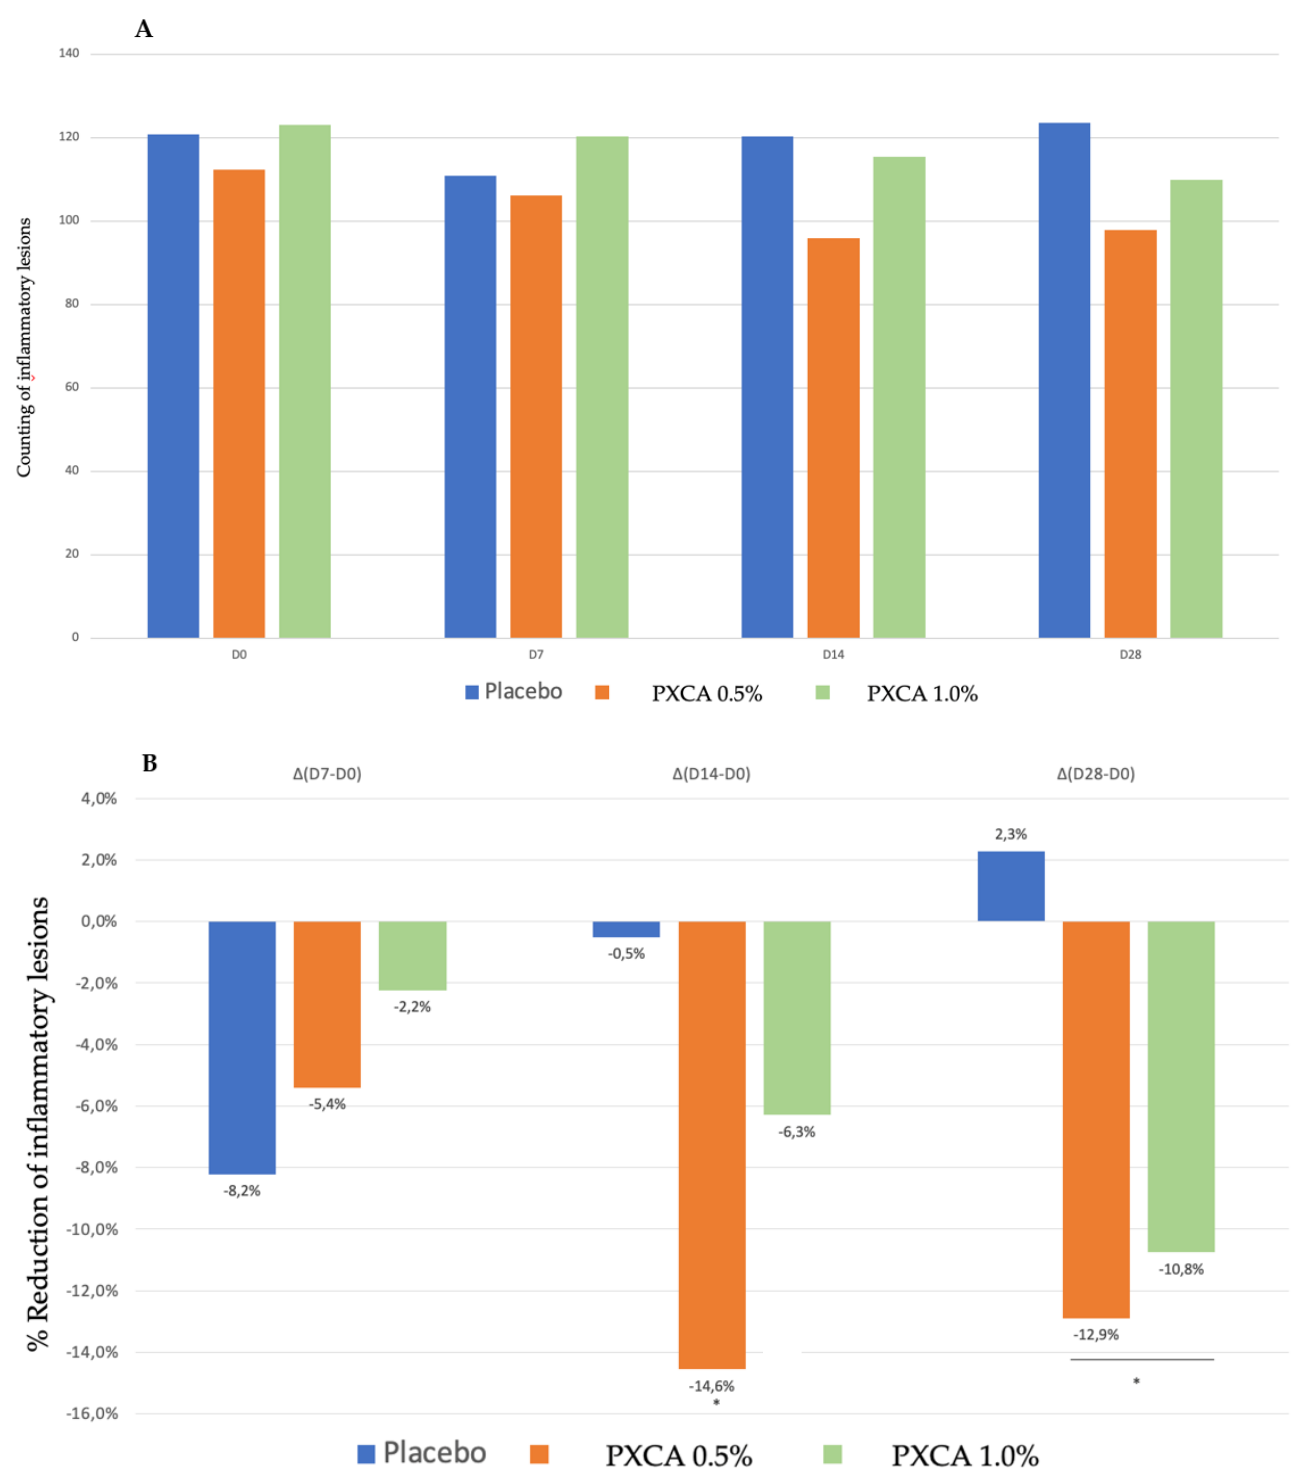
Figure 5. ( A ) Counts of the inflammatory lesions of the participants before the application of PXCA 0.5% (n = 15), 1.0% (n = 16) and placebo (n = 13) (D0) and after 7 (D7), 14 (D14) and 28 (D28) days of use. ( B ) Reduction in inflammatory lesions (%) for PXCA at 0.5% (n = 15), 1.0% (n = 16) and placebo (n = 13) per period of (D7 ‐ D0/D14 ‐ D0/D28 ‐ D0). * p < 0.05 in relation to the initial time (D0).